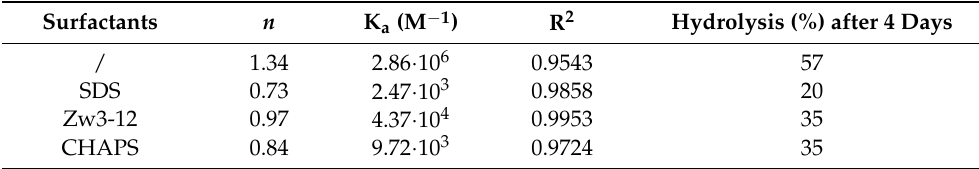
Table 2. The calculated binding constant ( K a ) and stoichiometry ( n ) of the protein complexes formed between Zr-K 1:2 and